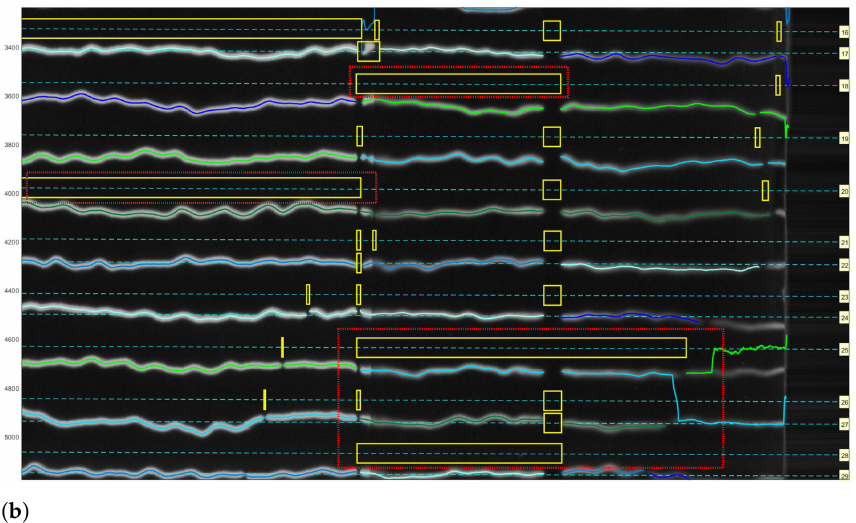
Figure 13. Identified traces for selective correction and re-digitising using Correct Trace mode. ( a ) Identified wrong vector direction of line crossing individual traces. ( b ) Detected misclassifications caused erroneous digitising. The gaps on the zero-lines (small yellow boxes) show the gaps that existed in the old paper in the original image itself. Differently colored lines are used to distinguish the segments of the traces.